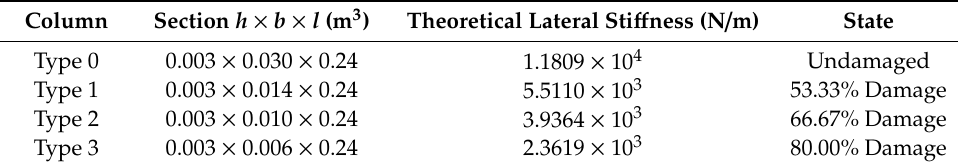
Figure 15. Experimental setup of five ‐ story shear framework model. ( a ) Five ‐ story shear building model ( b ) 4 types of columns. ( c ) Size of columns. Table 3. Specific physical parameters of the columns. Table 3. Specific physical parameters of the columns.